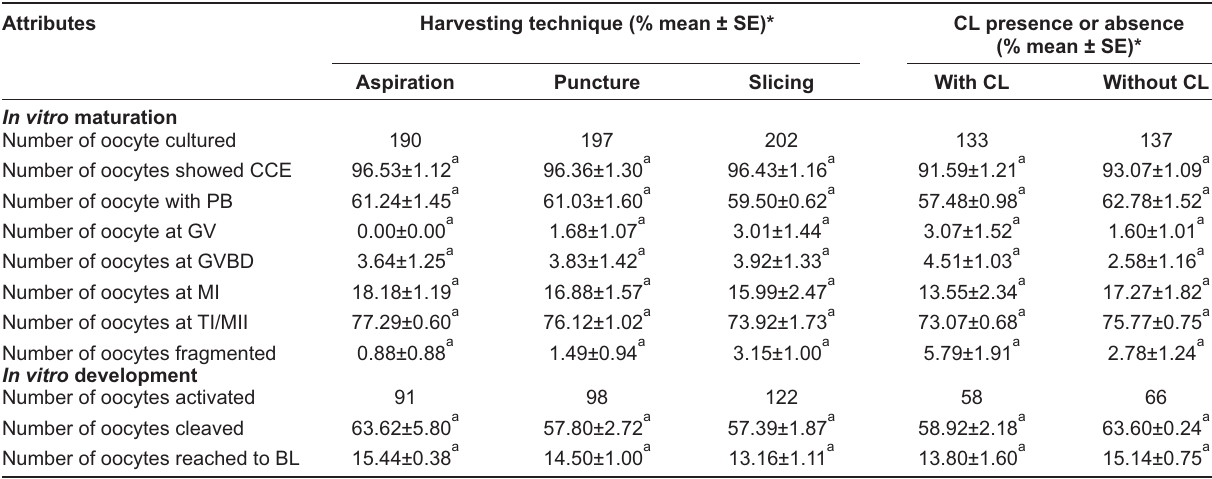
Table-2: Effect of different collection methods and presence or absence of corpus luteum (CL) on maturation and development of buffalo